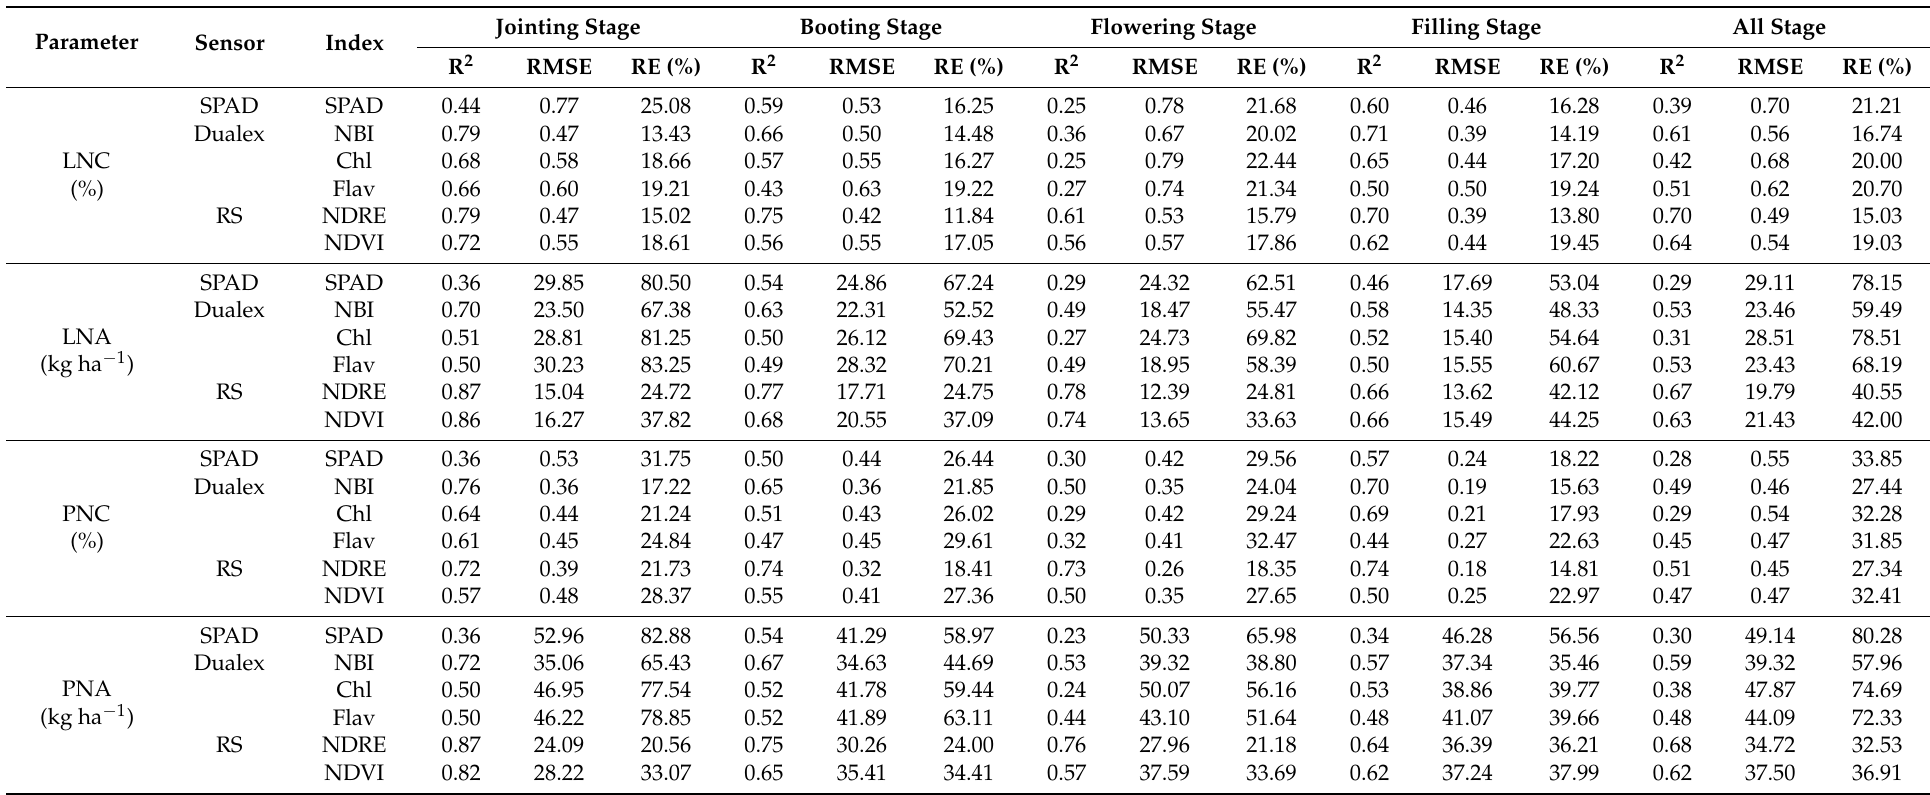
Table 4. Ten-fold cross-validation results for the pair-wise exponential relationship between the six sensor-based indices and leaf N concentration (LNC), leaf N accumulation (LNA), plant N concentration (PNC), and plant N accumulation (PNA) at different growth stages across experiments